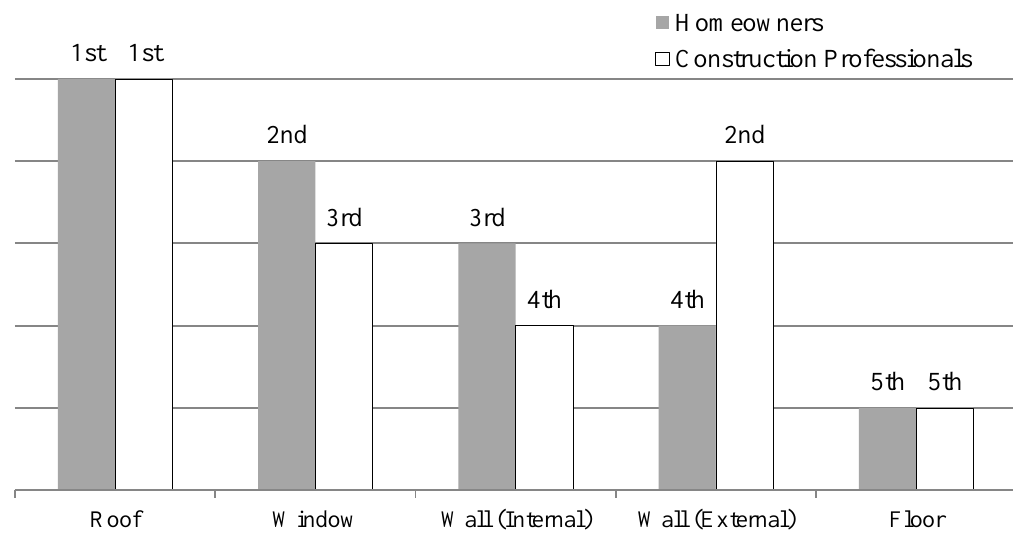
Figure 2. Refurbishment priorities for elements of a